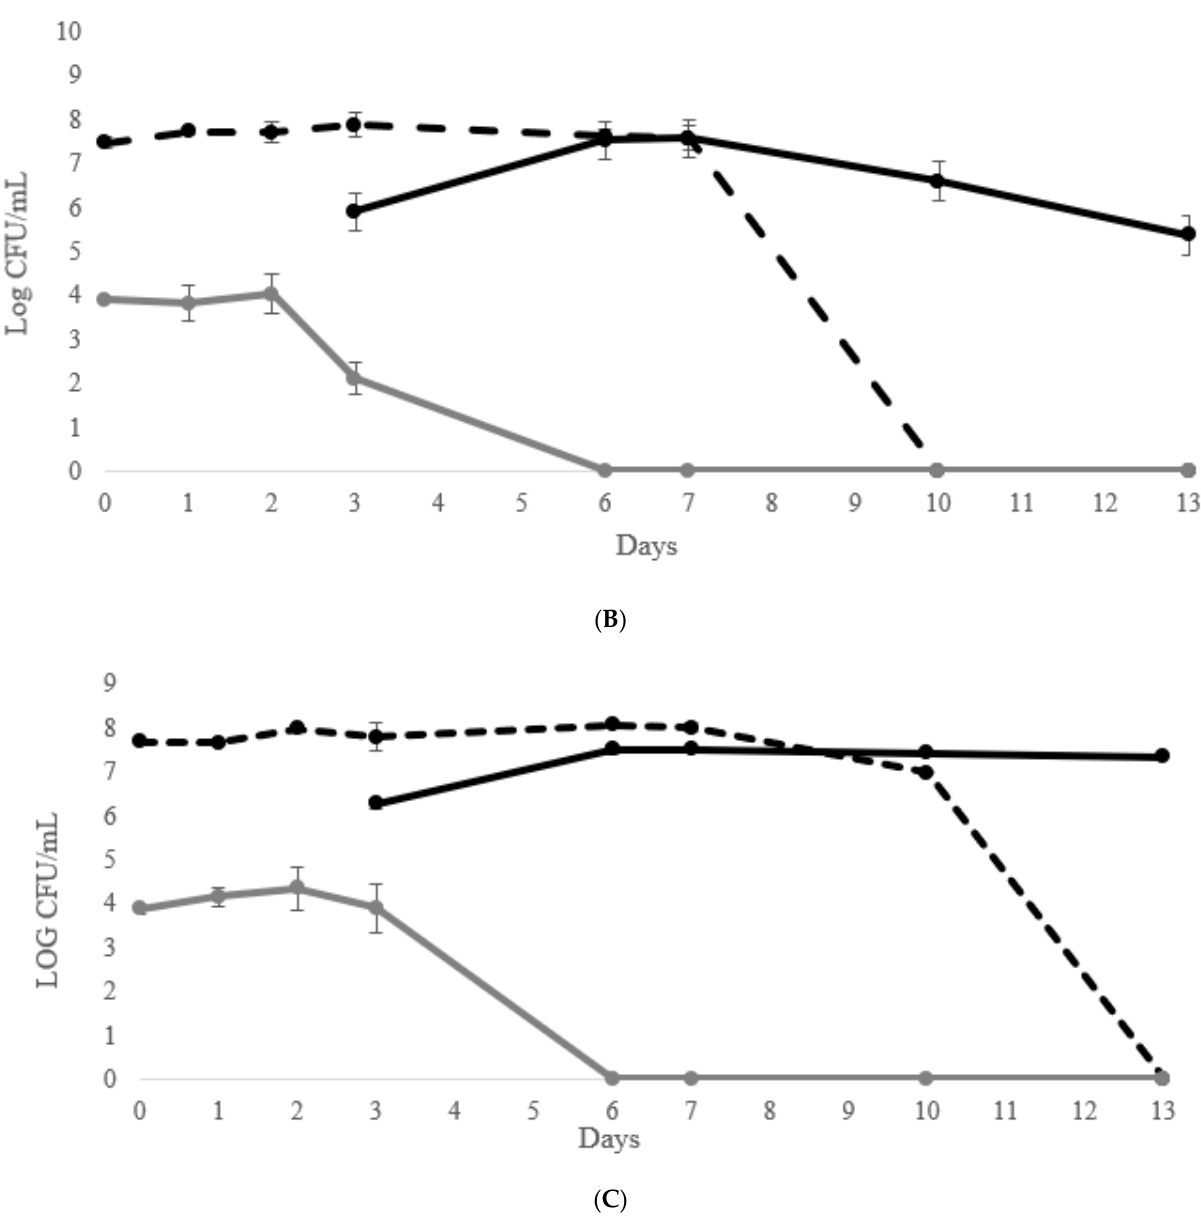
Figure 2. Growth kinetics in sequential fermentation trials S. bombicola / S. cerevisiae and control S. cerevisiae on natural grape juice (NGJ). ( ) S. cerevisiae; ( ) Wild non- Saccharomyces; ( ) S. bombicola . ( A ) control-pure fermentation with S. cerevisiae inoculum; ( B ) semi-aerobic condition (no aeration); ( C ) with aeration (20 mL/L min of air flux during the first 72 h).